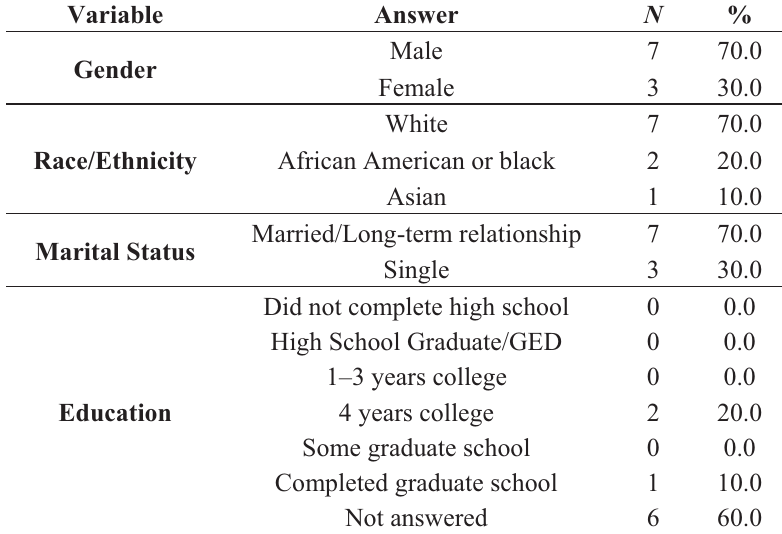
Table 2. Demographics for small bowel obstruction (SBO) patients included in this